Question: Sum up the contents of this chart in one sentence.
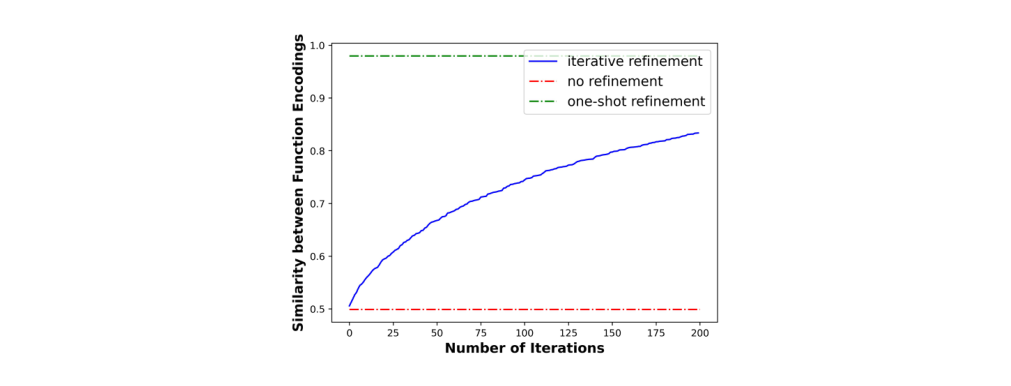
Answer: When encoding the same function under two different sample distributions, one-shot refinement can approximate the sample invariant function encoding well. It takes 75/90/1500 ms to encode 5000 samples on a CPU, and 7.5/8.0/250 ms on an NVIDIA Titan-X GPU when performing no refinement/one-shot refinement/200-step iterative refinement.